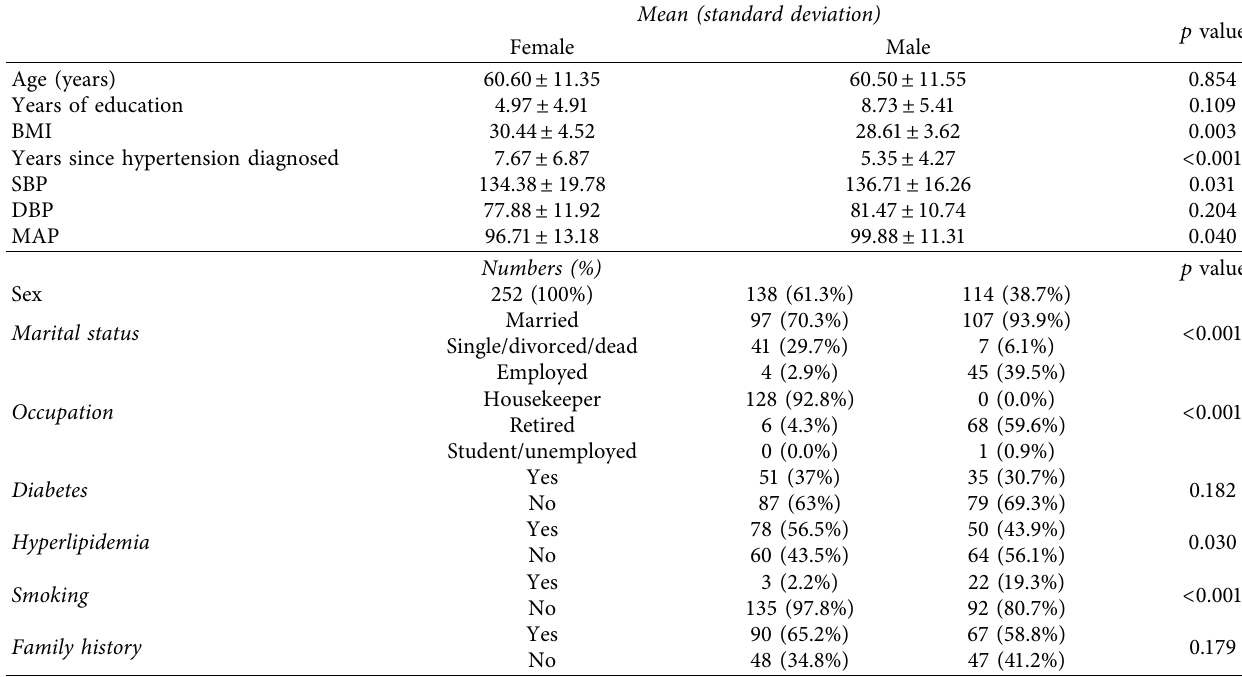
Table 1: The demographic and medical characteristics of the study population divided by sex. A p value < 0.05 was considered significant.